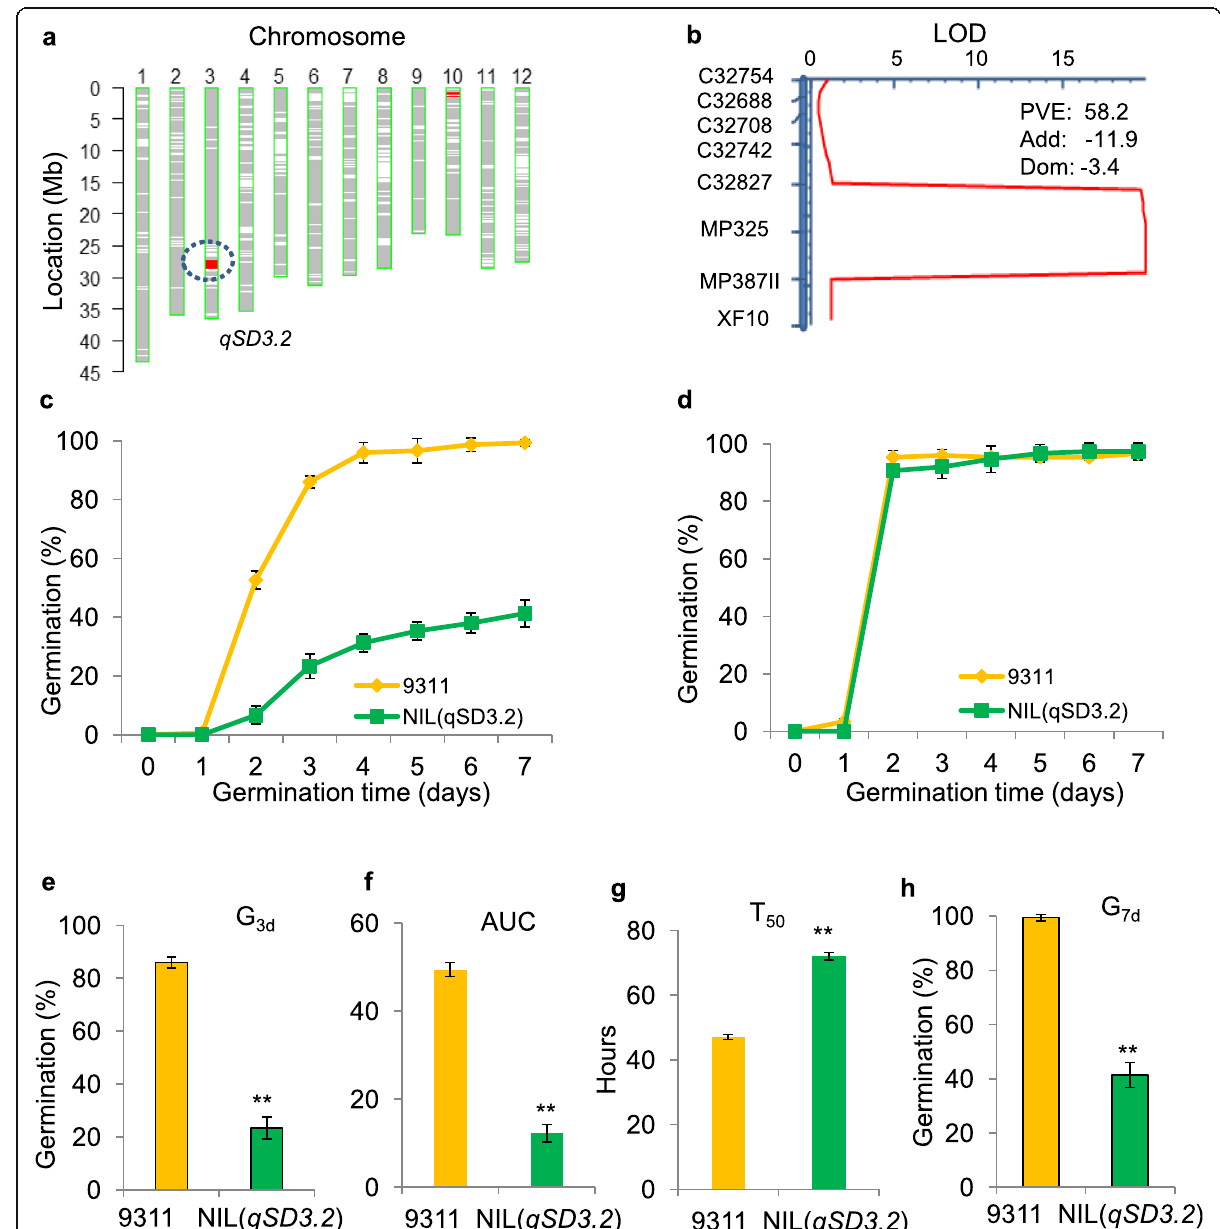
Fig. 3 Validation of the effect of qSD3.2 on seed dormancy. a Graphical genotype showing one CSSL (NY38) carrying an introduced Nipponbare segment encompassing qSD3.2 on chromosome 3 and a background Nipponbare segment on chromosome 10 in the 9311 background. b QTLs detected in the NY38-derived population ( n = 105). LOD, logarithm of odds; Add, additive effect; Dom, dominance effect; PVE, phenotypic variance explained by the QTL. c Germination curve of freshly harvested seeds of NIL ( qSD3.2 ) and 9311. d Germination curve of NIL ( qSD3.2 ) and 9311 seeds after dormancy breaks. e-h Germination behaviors of NIL ( qSD3.2 ) and 9311 seeds. G 3d ( e ), AUC ( f ), T 50 ( g ) and G 7d ( h ). G 3d , germination rate at 72 h after imbibition; G 7d , maximum germination rate at 168 h after imbibition; T 50 , germination speed, which is the time to reach 50% germination of seeds; and AUC, the area under the curve until 168 h after imbibition. The error bar represents the mean ± SD ( n = 3). Double asterisks denote significant differences at P <